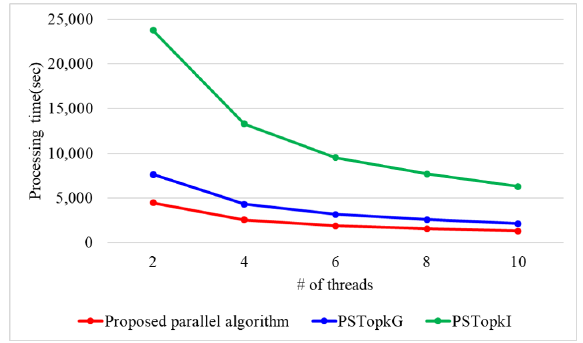
Figure 12. Processing time with a varying number of threads.